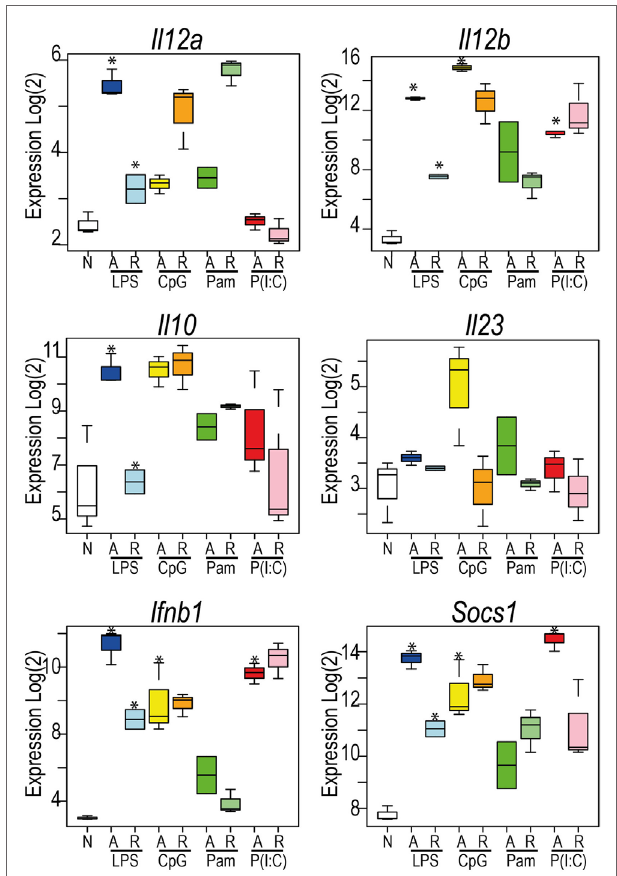
FigUre 5 | Toll-like receptors exhibit distinct patterns of tolerance. Microarray profiles of Il12a , Il12b , Il23a , Ifnb1 , Socs1 , and Il10 . Y -axis: Log 2 expression. X -axis: conditions. See also Figures S2–S4 in Supplementary Material. Box and whisker plots are median, min, and max. n = 2–3. *indicates Benjamini and Hochberg adjusted p <